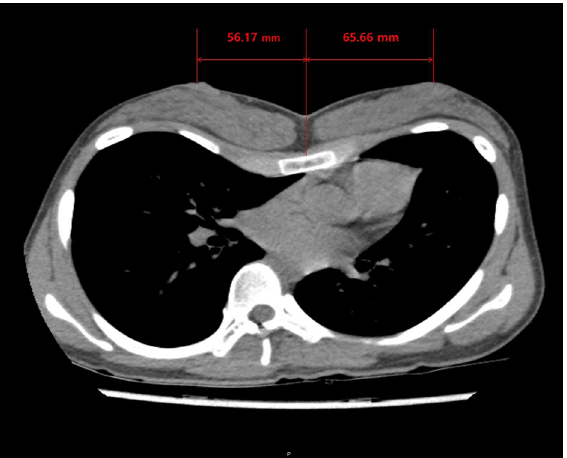
Figure 3. Measuring the distance between the nipples. Each distance from the sternal midline to the right and left nipples based on chest computerized tomography (CT) was measured and the distance between the nipples was calculated as the sum of the right and left